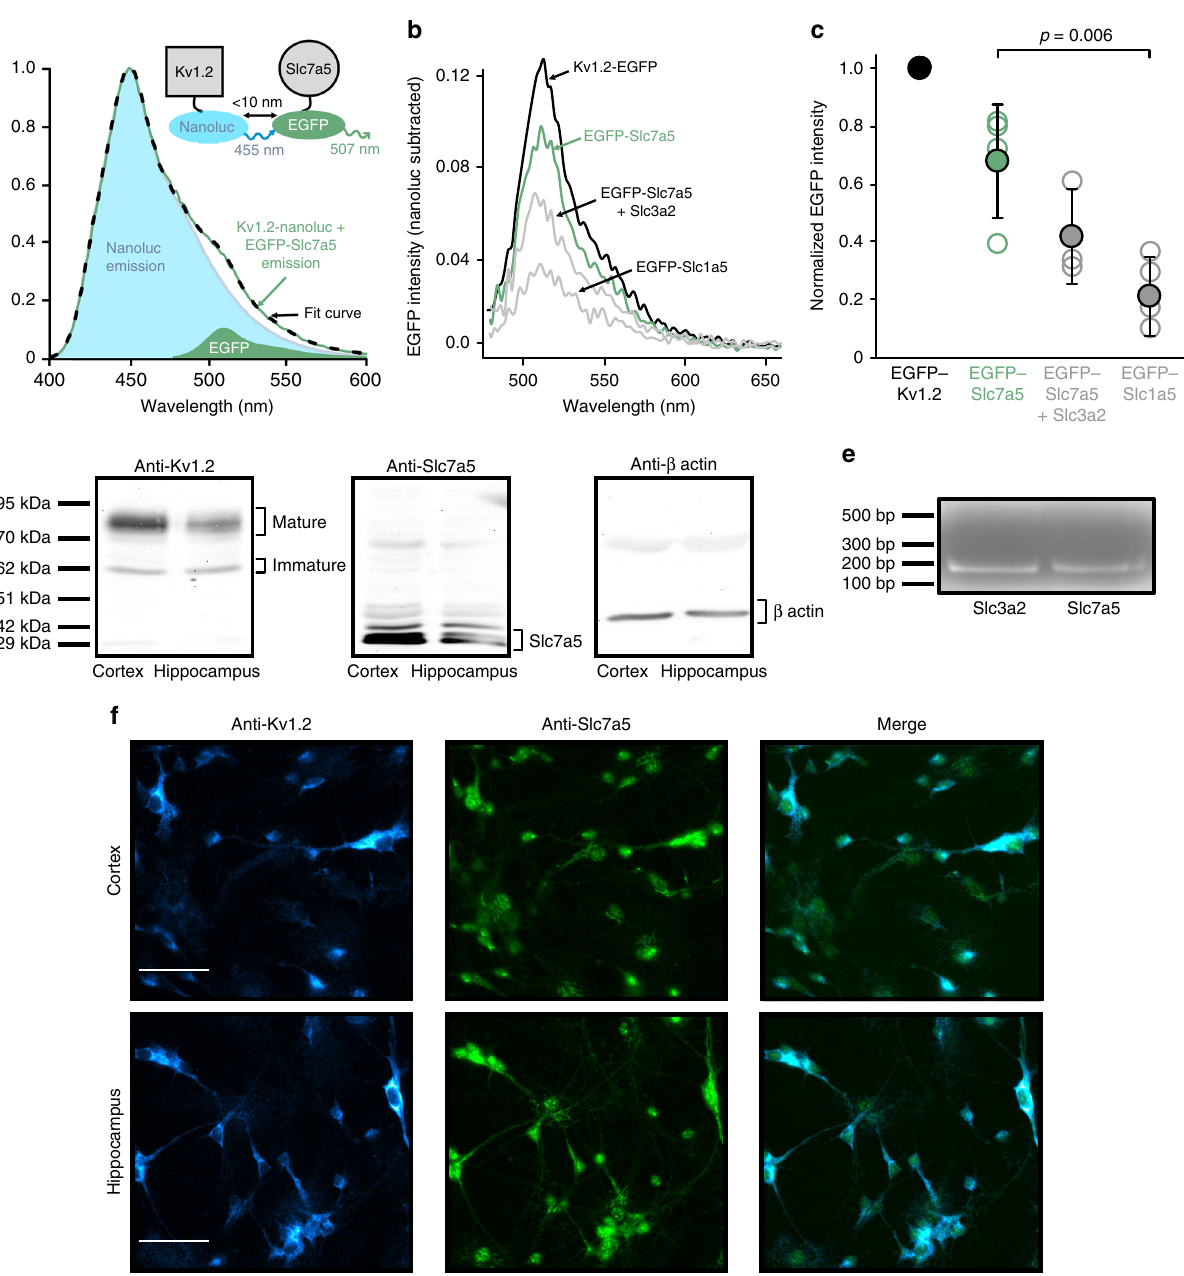
Fig. 6 Measurement of the proximity of Slc7a5 and Kv1.2 with bioluminescence resonance energy transfer (BRET). a Emission spectra were collected from HEK293 cells transfected with Kv1.2-nanoluc + EGFP-Slc7a5 (green line normalized to peak). The Kv1.2-nanoluc (donor) spectrum was subtracted to yield the mEGFP component. Weighted components of the nanoluc (1.0) and mEGFP (0.1) spectra were used to fi t the experimental spectrum (black dashed line). b mEGFP fl uorescence (nanoluc-subtracted) was measured for Kv1.2-nanoluc co-expressed with various acceptor constructs, as indicated. c The area under the curve (AUC) for each BRET acceptor in b was normalized to the positive control AUC (Kv1.2-EGFP). Data are shown as mean ± SD ( n = 4 – 5). ANOVA and a Tukey post hoc test were used to compare the BRET signals from EGFP-Slc7a5 (±Slc3a2) and EGFP-Slc1a5. d Western blot of dissociated cortical and hippocampal neurons from P2 rat pups at 14 days in vitro blotted with anti-Kv1.2 (left), anti-Slc7a5 (middle) and anti- β actin (right). e RT-PCR of Slc7a5 and Slc3a2 from dissociated cortical neurons from P1 rat pups after 4 days in vitro. f Cortical and hippocampal neurons from P2 rat pups at 7 days in vitro fi xed with 4% paraformaldehyde, permeabilized with 1% Triton X-100 and stained with anti-Kv1.2 and anti-Slc7a5 primary antibodies as in d and fl uorescent secondary antibodies. Images are representative of three neuronal cultures. Scale bars represent 50 µ